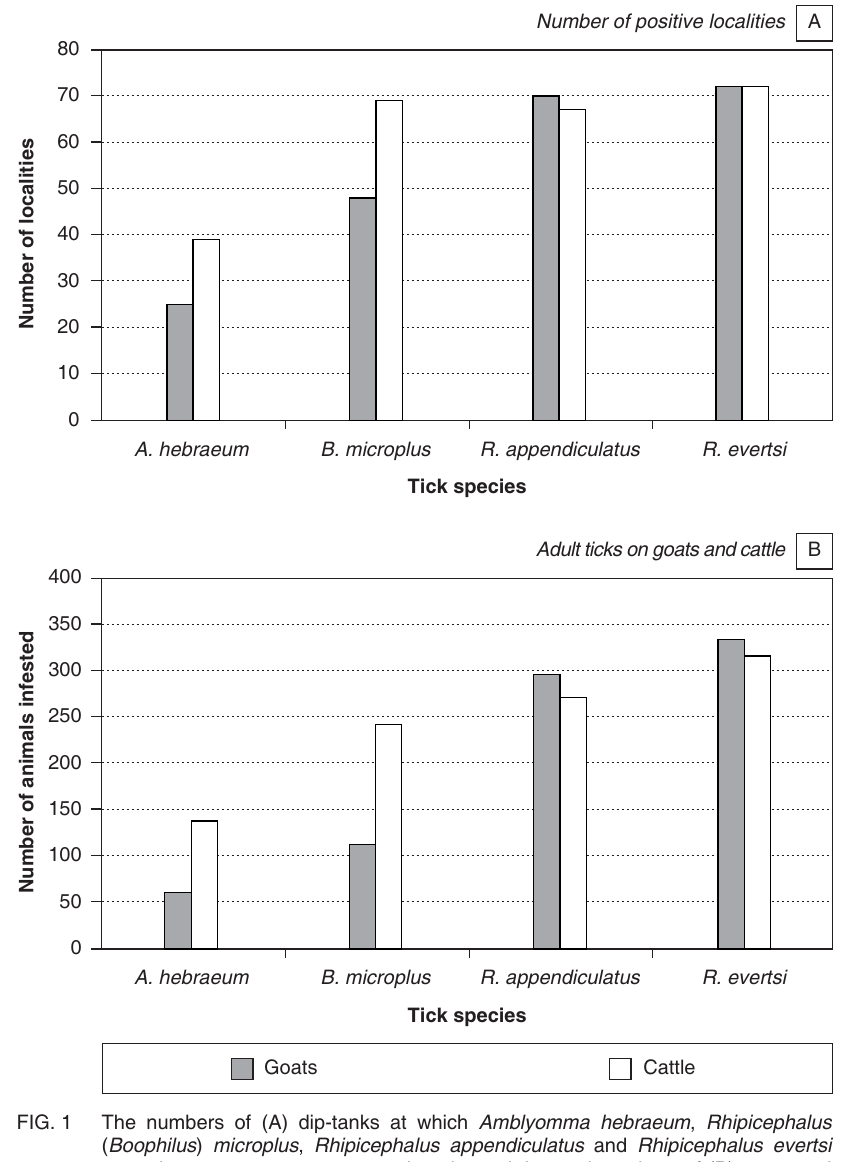
FIG. 1 The numbers of (A) dip-tanks at which Amblyomma hebraeum , Rhipicephalus ( Boophilus ) microplus , Rhipicephalus appendiculatus and Rhipicephalus evertsi evertsi were present on goats and cattle, and the total numbers of (B) goats and cattle on which these ticks were present at 72 dip-tanks in the eastern region of the Eastern Cape Province, South